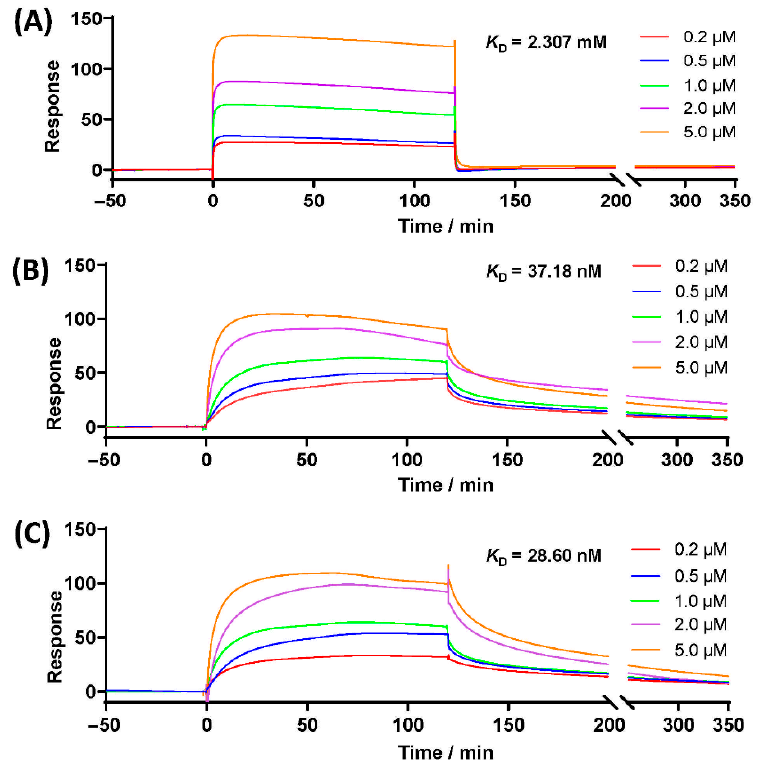
Figure 9. SPR biosensor analysis: ( A ) poor affinity between vehicle and spike protein ( K D = 2.307 mM); ( B ) favorable binding of RDV and spike protein ( K D = 37.18 nM); ( C ) the binding would not be blocked by hydrogel carrier ( K D = 28.60 nM).